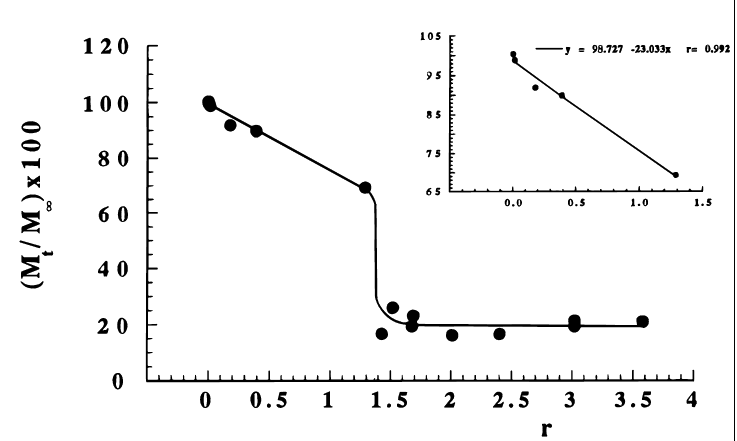
Effect of Ca ( r ) on the percentage of TPH released, after 8 h, from tablets prepared with the CCP polymer and containing increasing amounts of CaCl . Inset: linear relationship between percentage released and r values. 2 Experiments were carried out in phosphate buffer (pH=7.4) at 37 °C.